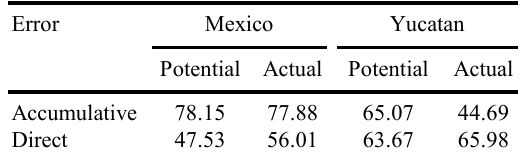
Table 3. Error between direct change and accumulative annual change maps between 2005 and 2010 for Mexico and Yucatan.